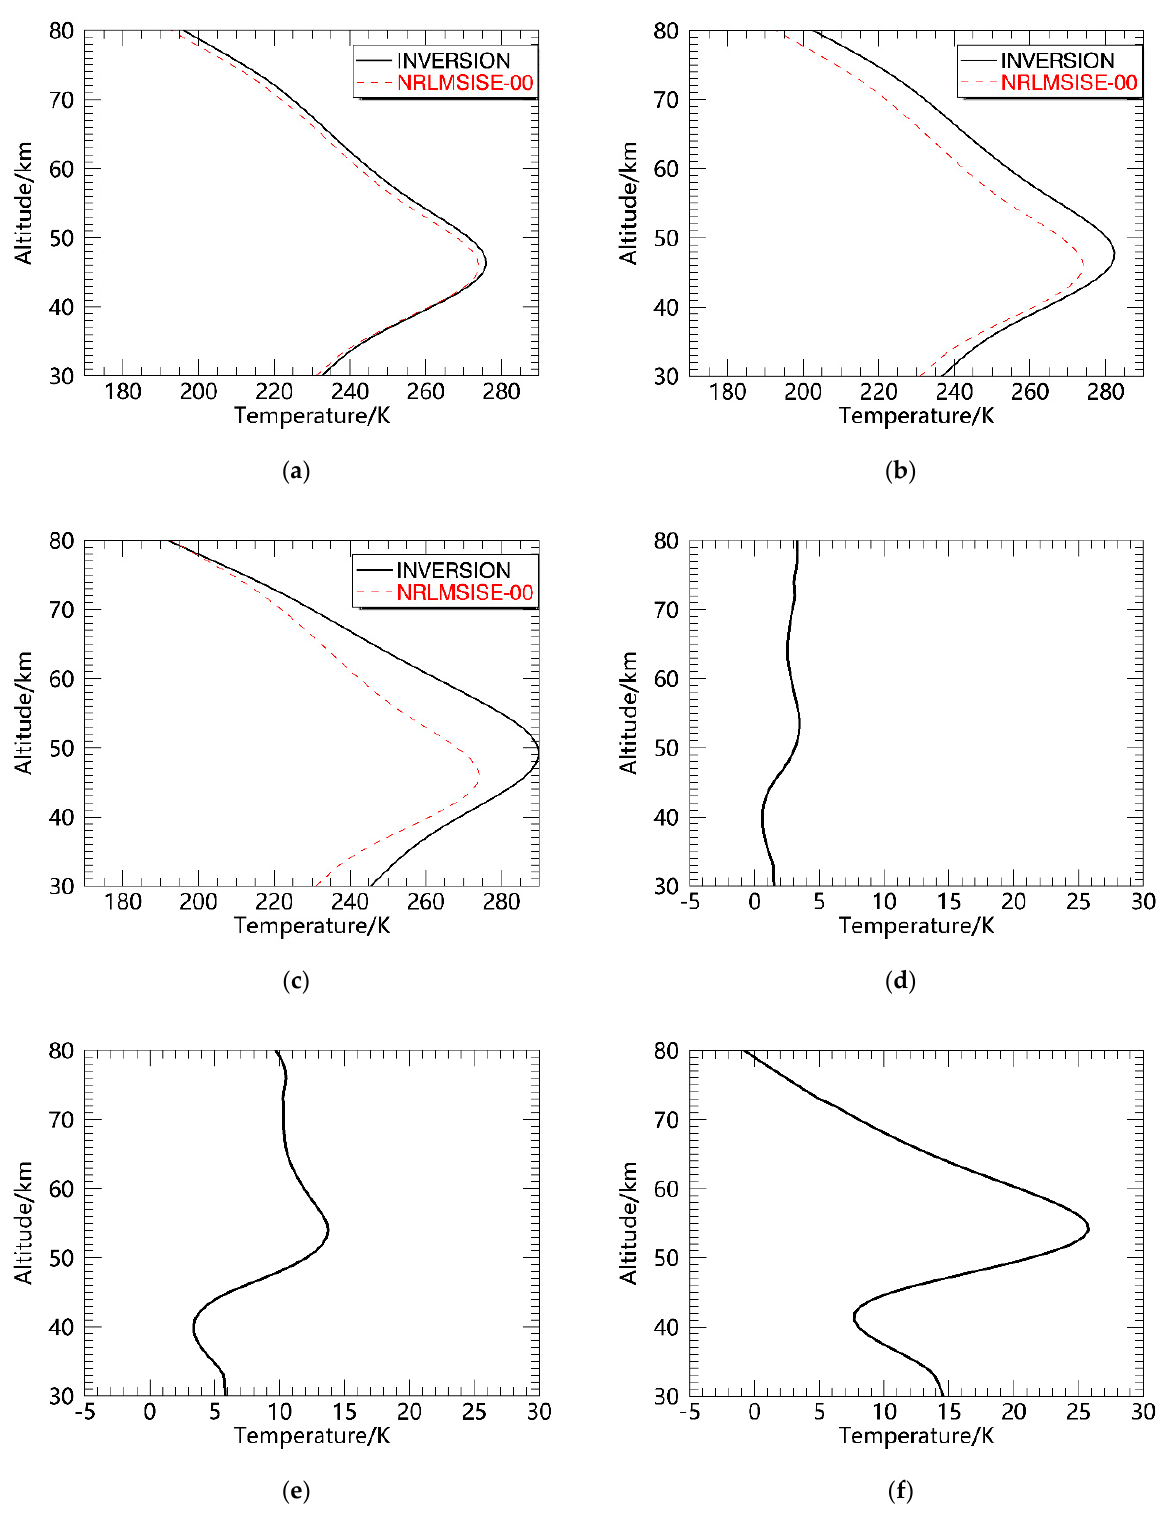
Figure 7. (a–c) Comparison of temperature profiles between the inversion and NRLMSISE-00 model from 30 km to 80 km with roll angles of 10°, 20°, and 30° on the precondition that the settled observation angle is 0°. (d–f) Deviation in temperature profiles between the inversion and NRLMSISE-00 model from 30 km to 80 km with roll angles of 10°, 20°, and 30° on the precondition that the settled observation angle is 0°.